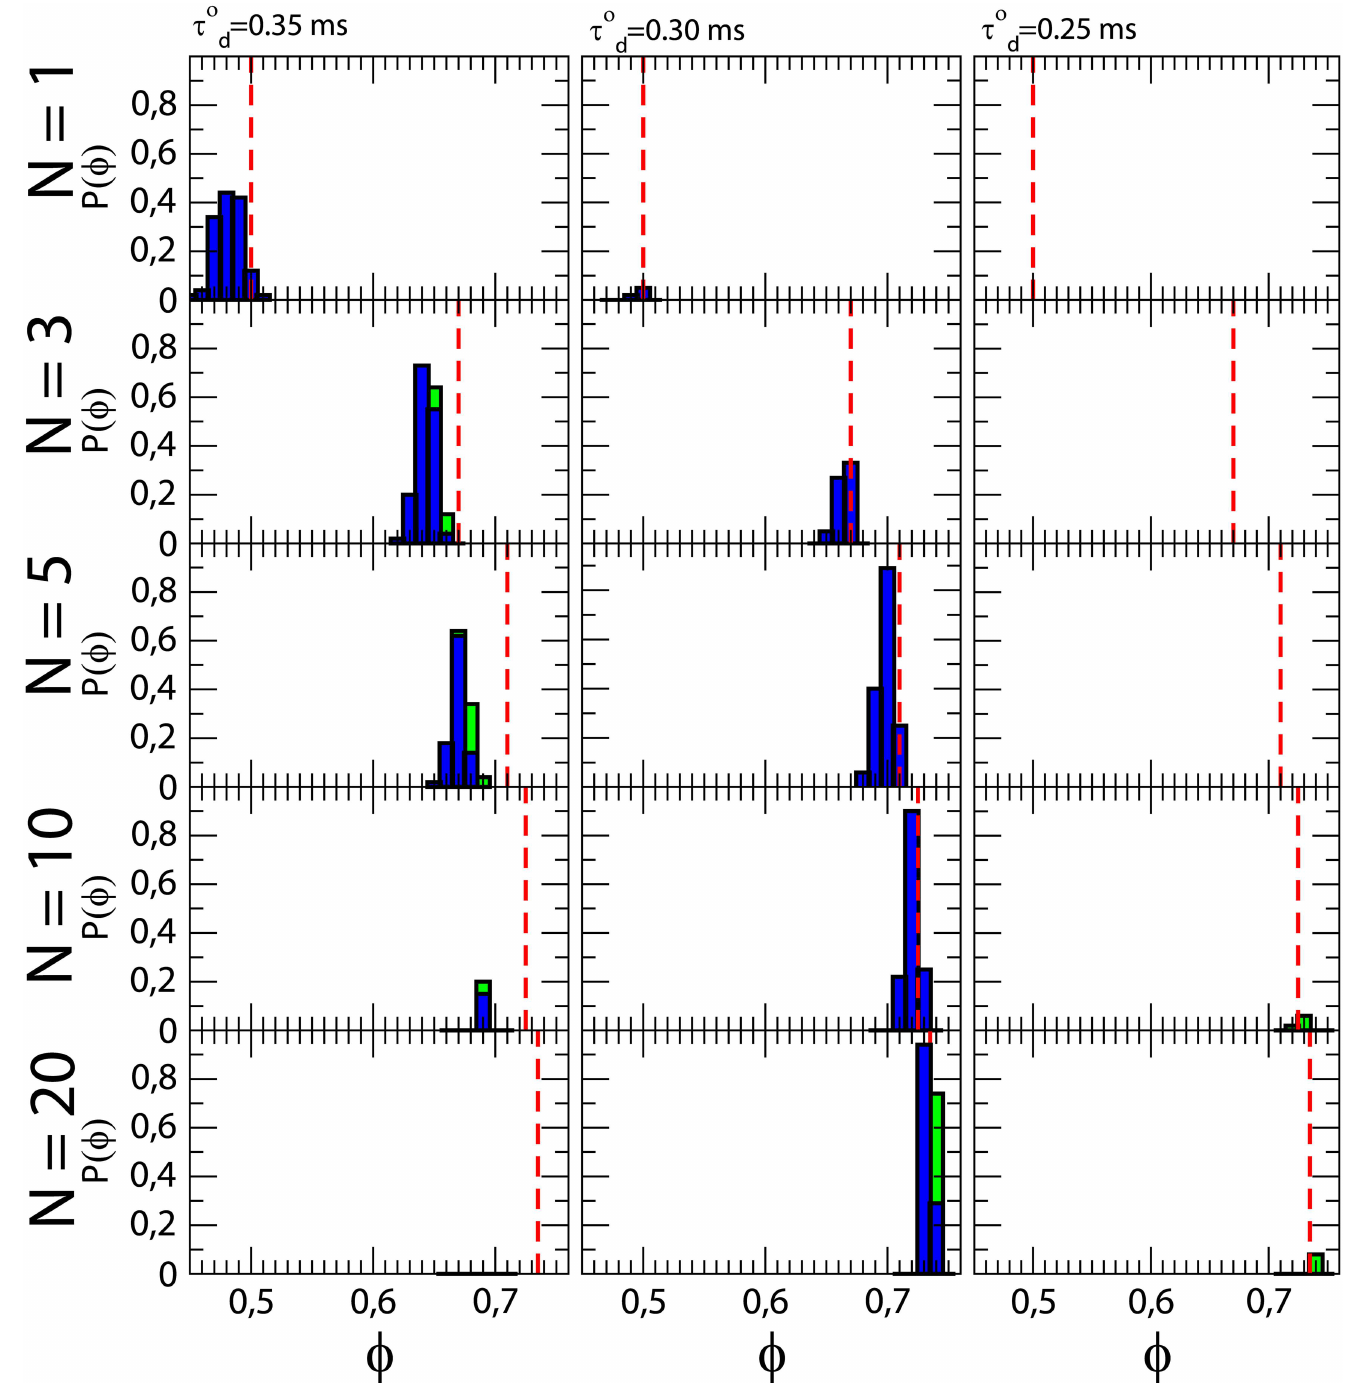
Fig 6. Dependence of the reentry probability on thickness and excitability. Columns correspond to three different values of the parameter t o the fibrotic regioncorrespondingto three different excitabilities. Outside this region τ d = 0.25 ms . Rows correspond to five different thickness of the three- dimensional slab of tissue ( N ). For each value of t o and N the dependenceof the probabilityof reentry as function of ϕ is plotted. For each value of ϕ two d types of reentriesare plotted: full Reentry (blue) and confined Activity (green). Dashedlines correspondto the percolationthreshold value. Parameter values: system size varies from 4 × 4 × 0.01 cm 3 ( N = 1 layer) to 4 × 4 × 0.2 cm 3 ( N = 20 layers), radius of the fibrotic region R o = 1.4 cm , and total time of simulation t = 1500 ms